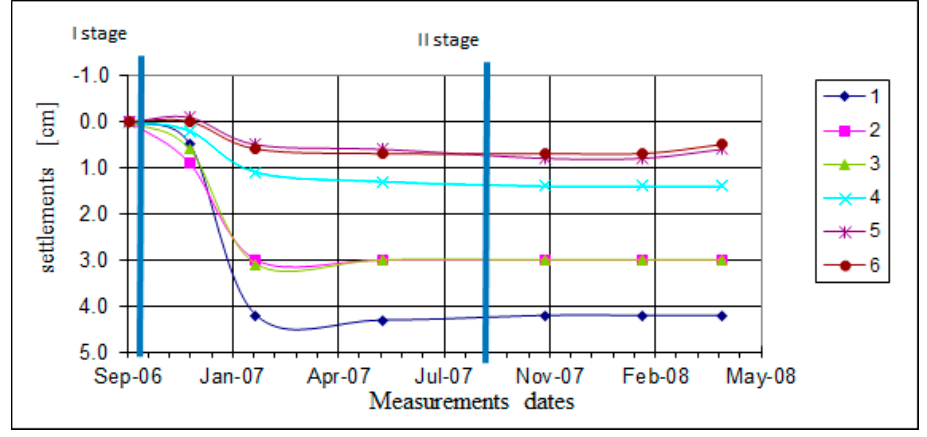
Figure 17. Buildings of the “Oak Terraces” housing estate in Katowice (project visualization, adver- tising materials, Tringranit).